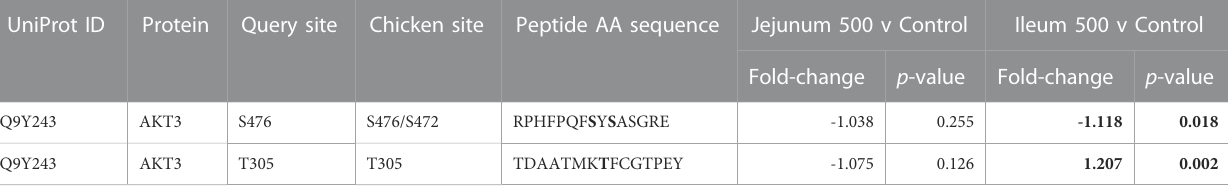
TABLE5AKT3andrelatedproteins ’ phosphorylationevents.Here,thekinomepeptidearrayresultsareshown.Jejunum500andileum500werecomparedtotheir respective control tissues. Phosphorylation events represented in this table show signi fi cant ( p -value < 0.05) for sites as described above. Signi fi cant values are highlighted in